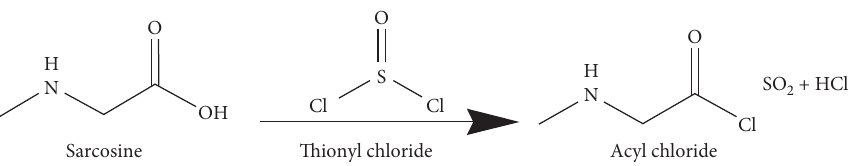
Figure 3: Reaction between sarcosine and thionyl chloride.